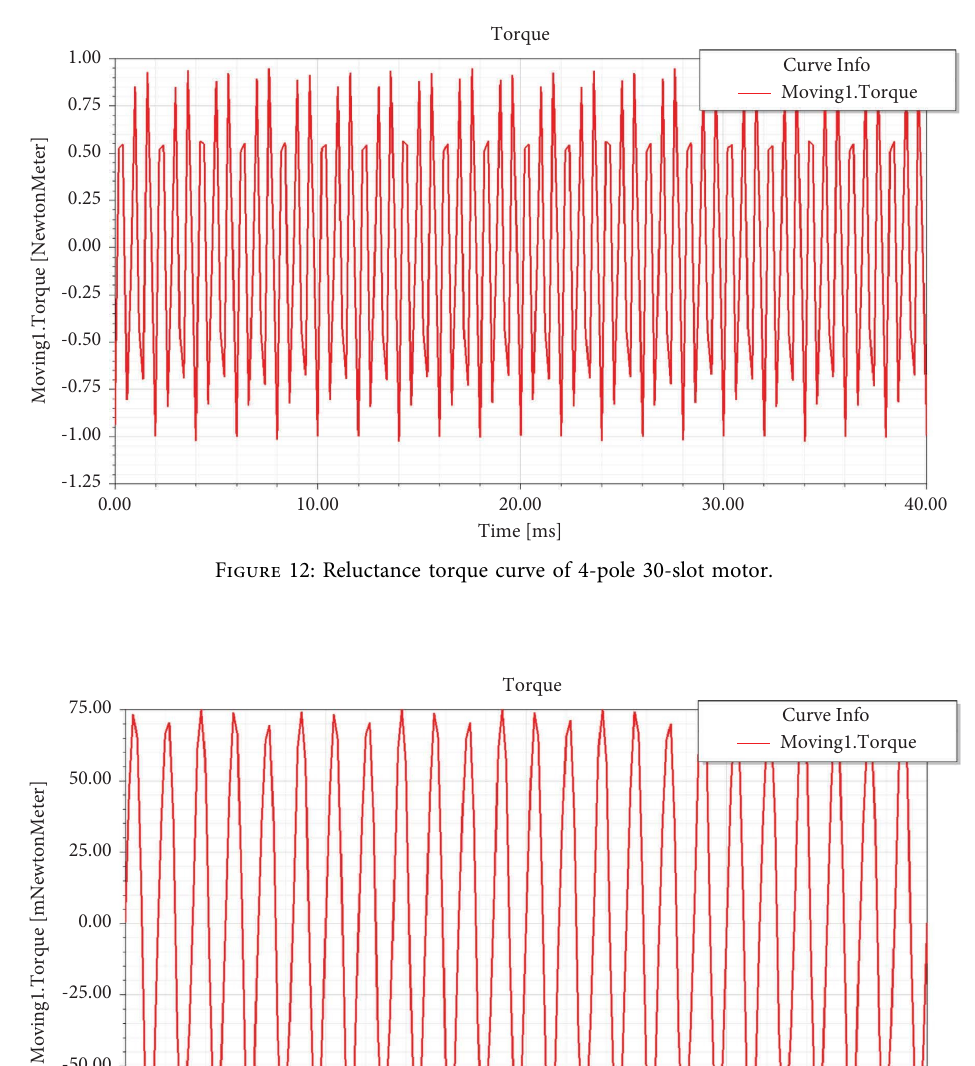
Figure 13: Magnetic resistance torque curve of 2-pole 24-slot